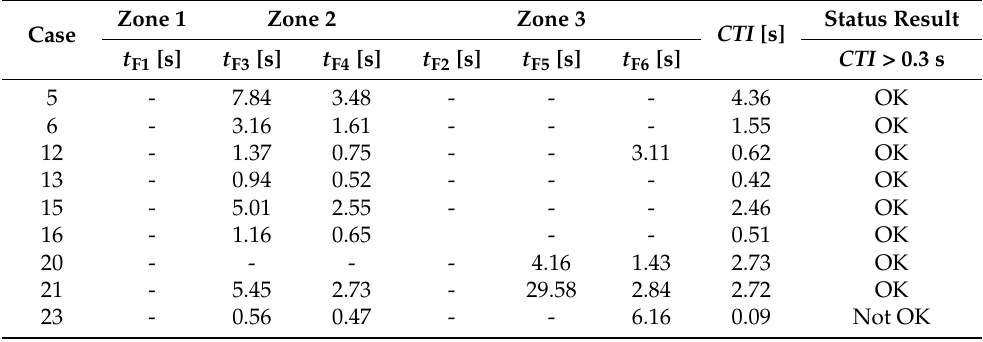
Table 8. IEEE 13-bus feeder system (Figure 6), simulated considering PV nodes. Fuse coordination results (tripping times) and compliance in cases where two consecutive fuses tripped (see Table 6).